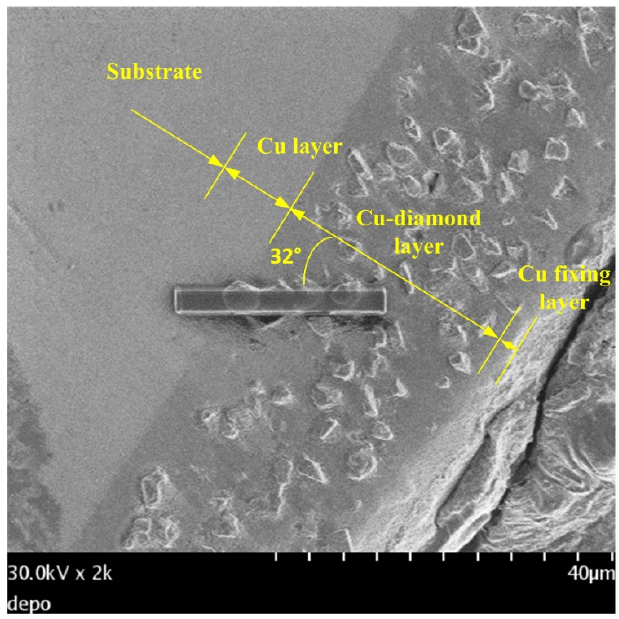
Figure 8. Cross-sectional view of the coating of specimen B.